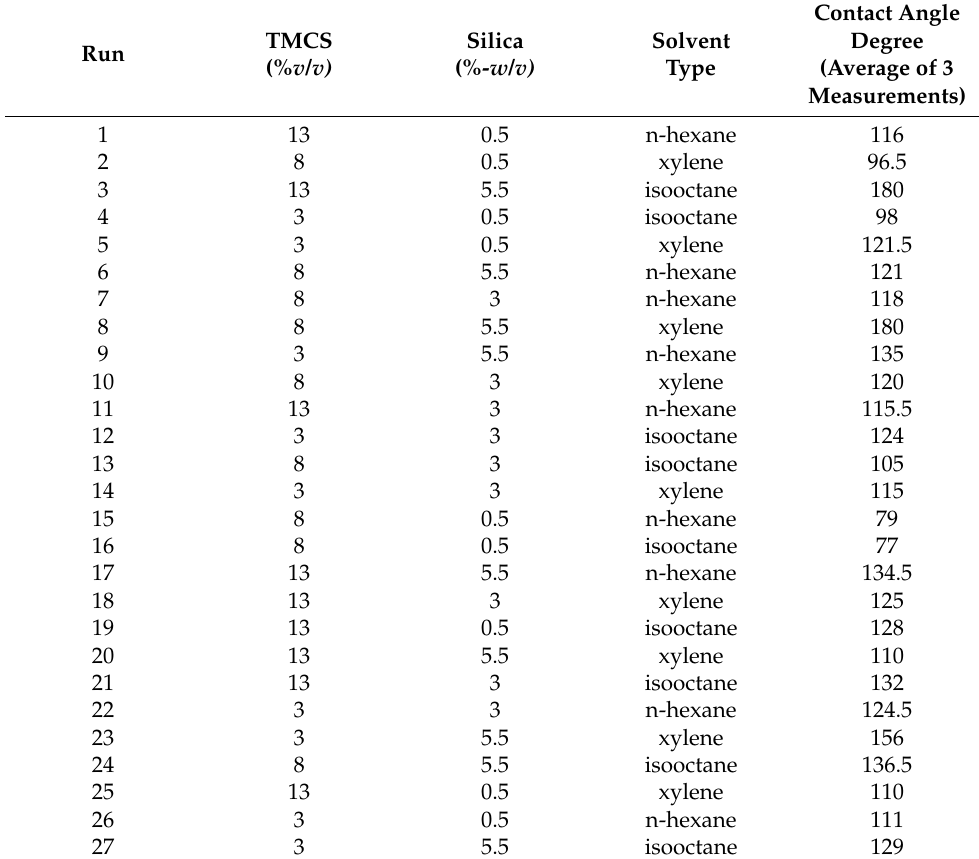
Table 4. Contact angle response with trimethylchlorosilane